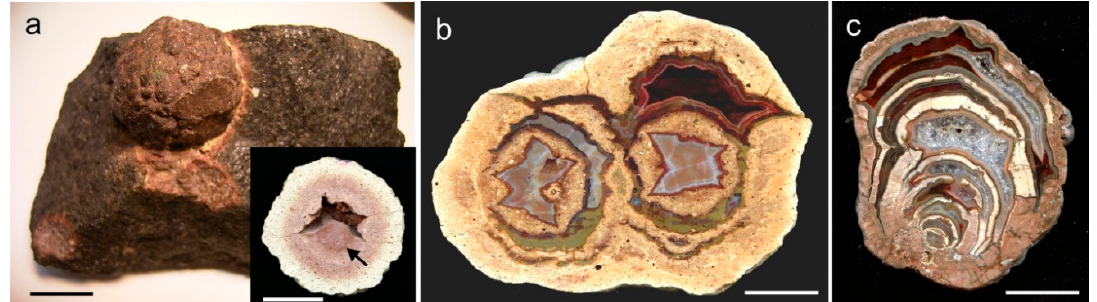
Figure 25. Different kinds of lithophysae with agates in silica ‐ rich volcanic rocks: ( a ) lithophysa in an ignimbritic pitchstone from Zwickau, Saxony (Germany); the inset shows a lithophysa from Chemnitz, Saxony (Germany) with crystallization center (arrow) and empty cavity; ( b ) double ‐ lithophysa with multiple agate cavities from St. Egidien, Saxony, Germany; ( c ) thunderegg from the Baker Egg Mine, Deming (New Mexico, USA) with multiple crescent ‐ shaped agate cavities; scale bar is 2 cm.